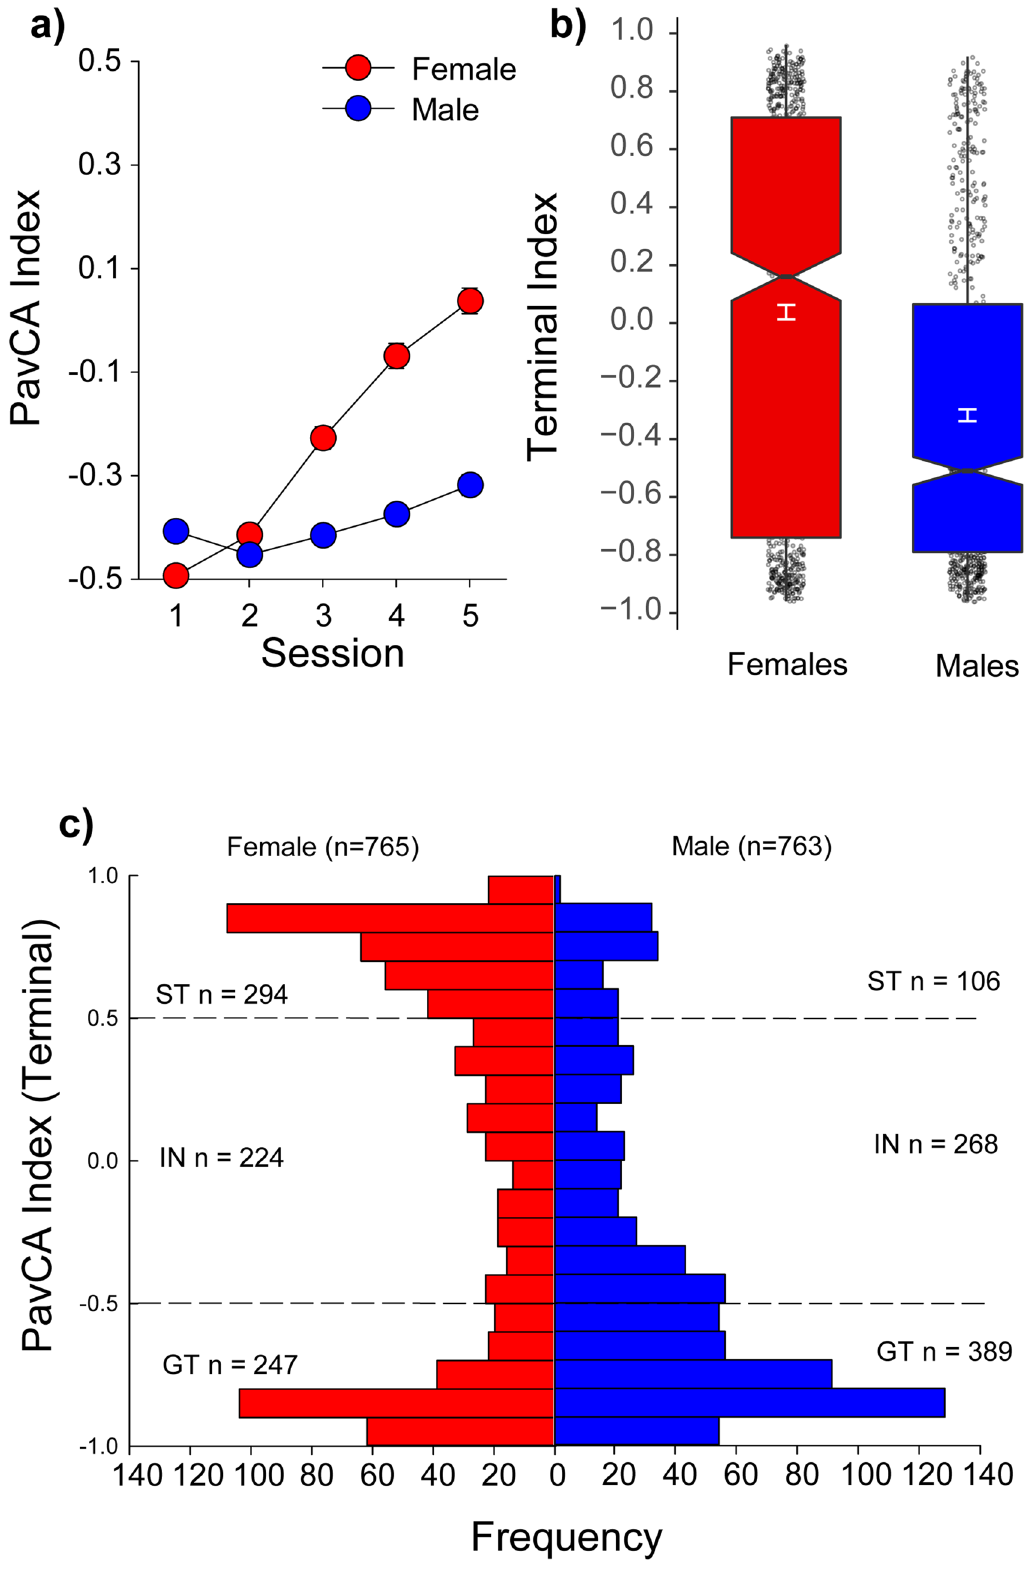
Figure 1. Sex differences during Pavlovian conditioned approach (PavCA) for the University at Buffalo Cohort (UBuff). Similar to the University of Michigan Cohort (UMich), across 5 sessions (total n = 1528), ( a ) female rats were more likely to sign-track compared to males. However, despite this group difference, at the end of conditioning there was substantial heterogeneity in each group ( c ), with both males and females showing a large number of intermediates, sign- and goal-trackers. ( b ) The distribution of subjects across the possible values for index is shown as a box plot. See text for a description of statistics described by the box